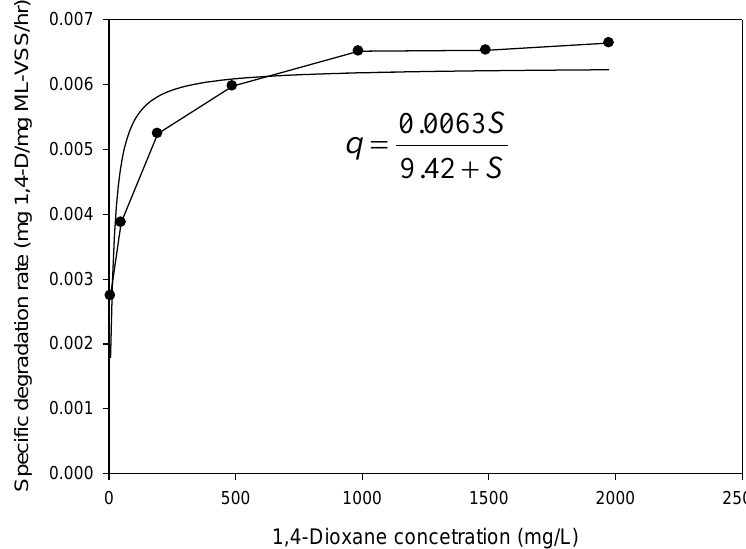
Figure 5. Monod plot of 1,4-dioxane degradation at various initial concentrations.